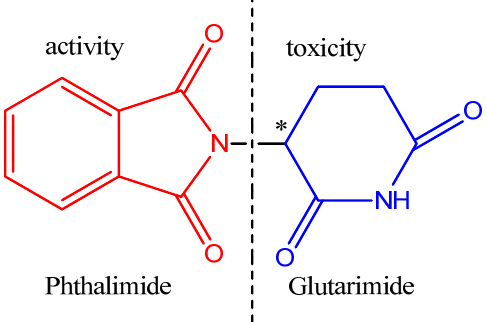
Figure 3. Pharmacophore and toxicophore group of